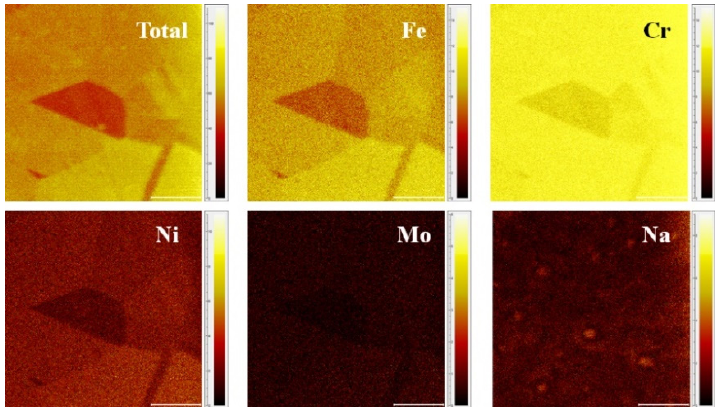
Figure 3. ToF-SIMS positive ions 2D-mapping of the sample (Scale bar: 100 μ m).